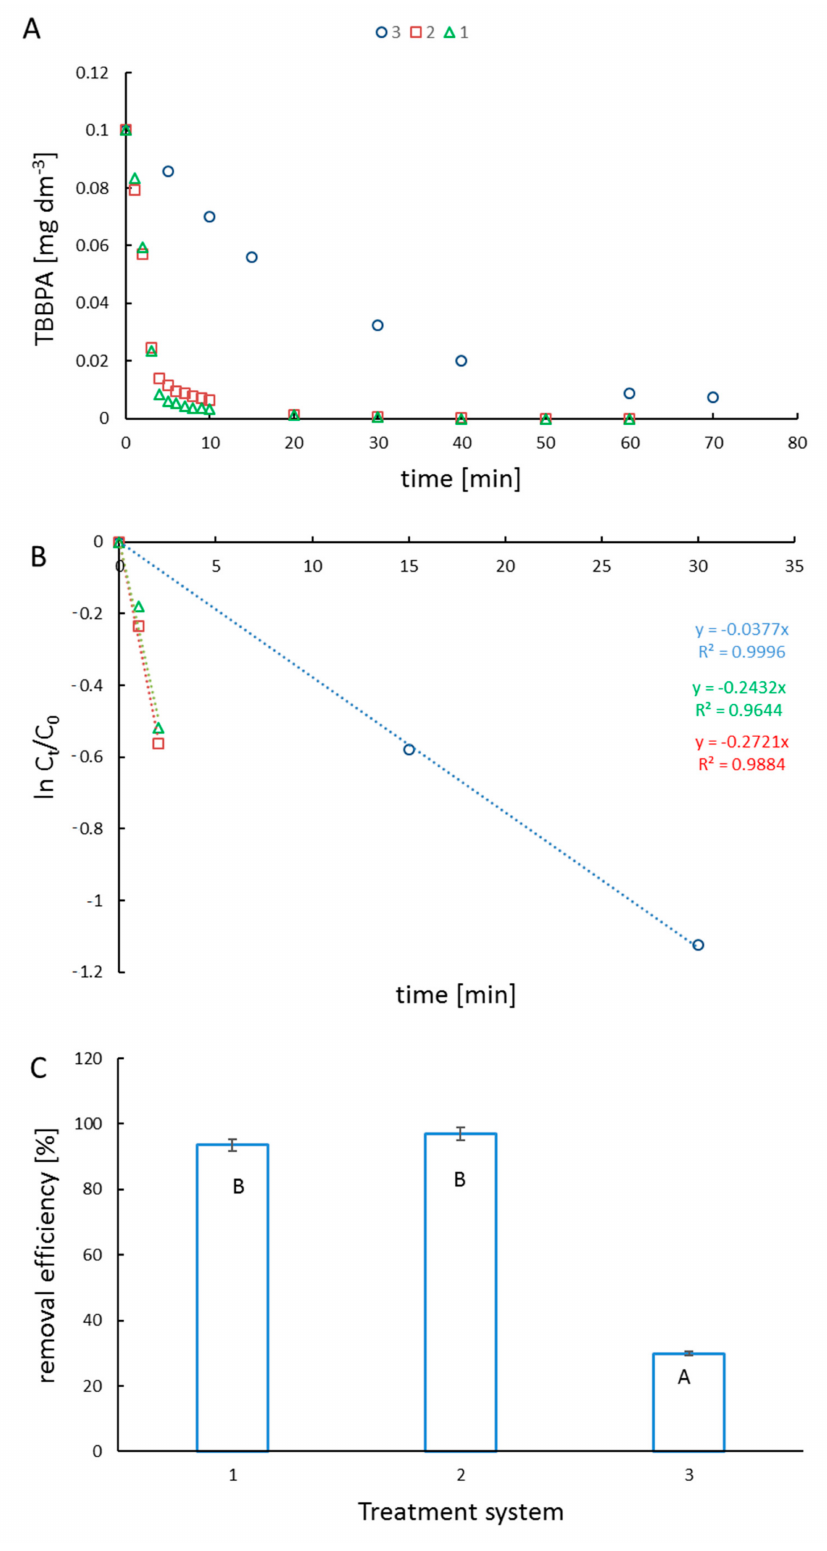
Figure 3. TBBPA decay rate in different degradation systems ( A ) (treatment system 1—triangles, 2— squares, 3—circles); plot of ln (C t /C 0 ) vs. irradiation time ( B ); removal efficiency in used